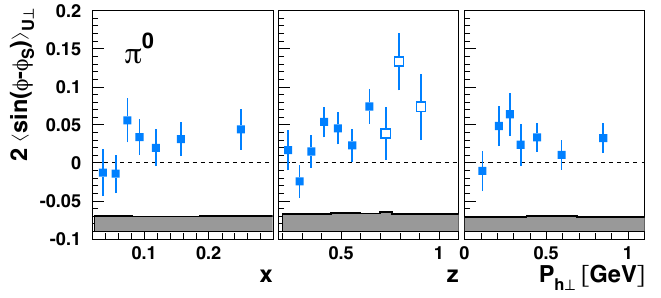
Figure 14 . Sivers SFA for π 0 presented either in bins of x , z , or P h ⊥ . Data at large values of z , marked by open points in the z projection, are not included in the other projections. Systematic uncertainties are given as bands, not including the additional scale uncertainty of 7.3% due to the precision of the target-polarization